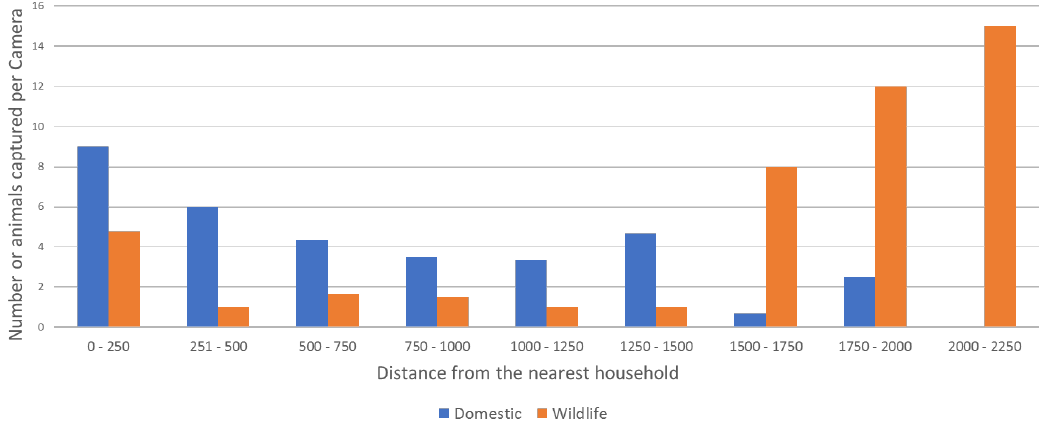
Figure 3. Number of domestic animals (dogs, dogs with owners, and cats) (blue) and other mammals and birds (orange) observed indirectly on remote-sensing cameras against the distance of the camera from the nearest house.